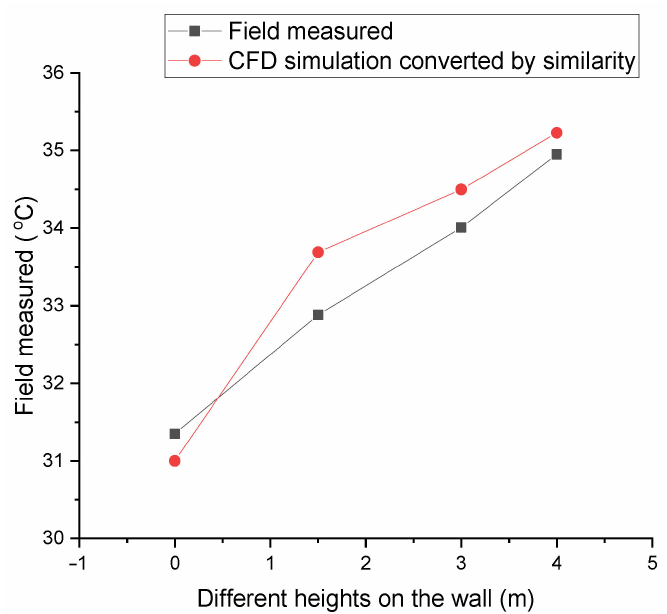
Figure 14. Temperature at di ff erent heights by measurement and computational flow dynamics (CFD) simulation in the street canyon. Energies 2020 , 13 , x FOR PEER REVIEW 15 of 20